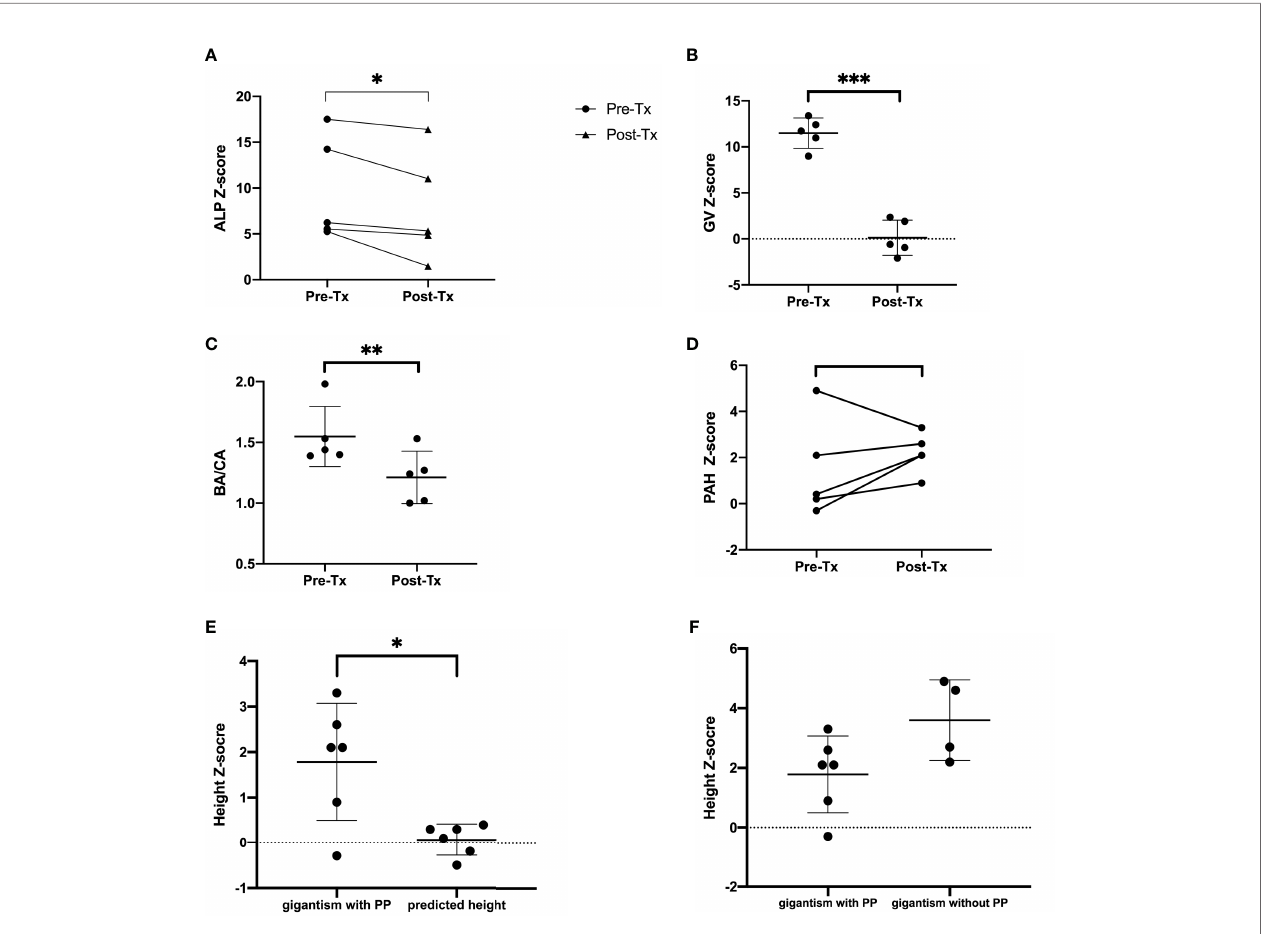
FIGURE 4 | ALP-Z score (A) , GV Z-score (B) , BA/CA ratio (C) , PAH Z-score (D) before and after treatment. The post-Tx data were collected at the last consultation for patients under therapy. (E) Final height or PAH Z-scores of patients diagnosed with gigantism and PP of MAS versus their predicted adult height. (F) Final height Z-scores of patients diagnosed with gigantism and PP versus fi nal height or PAH Z-scores of patients diagnosed with gigantism without PP. Tx, treatment; Pre-Tx, pretreatment; Post-Tx,posttreatment; ALP, alkaline phosphatase; GV, growth velocity; BA/CA, bone age over chronological age; PAH, predicted adult height. ***P < 0.001, **P < 0.01, *P <